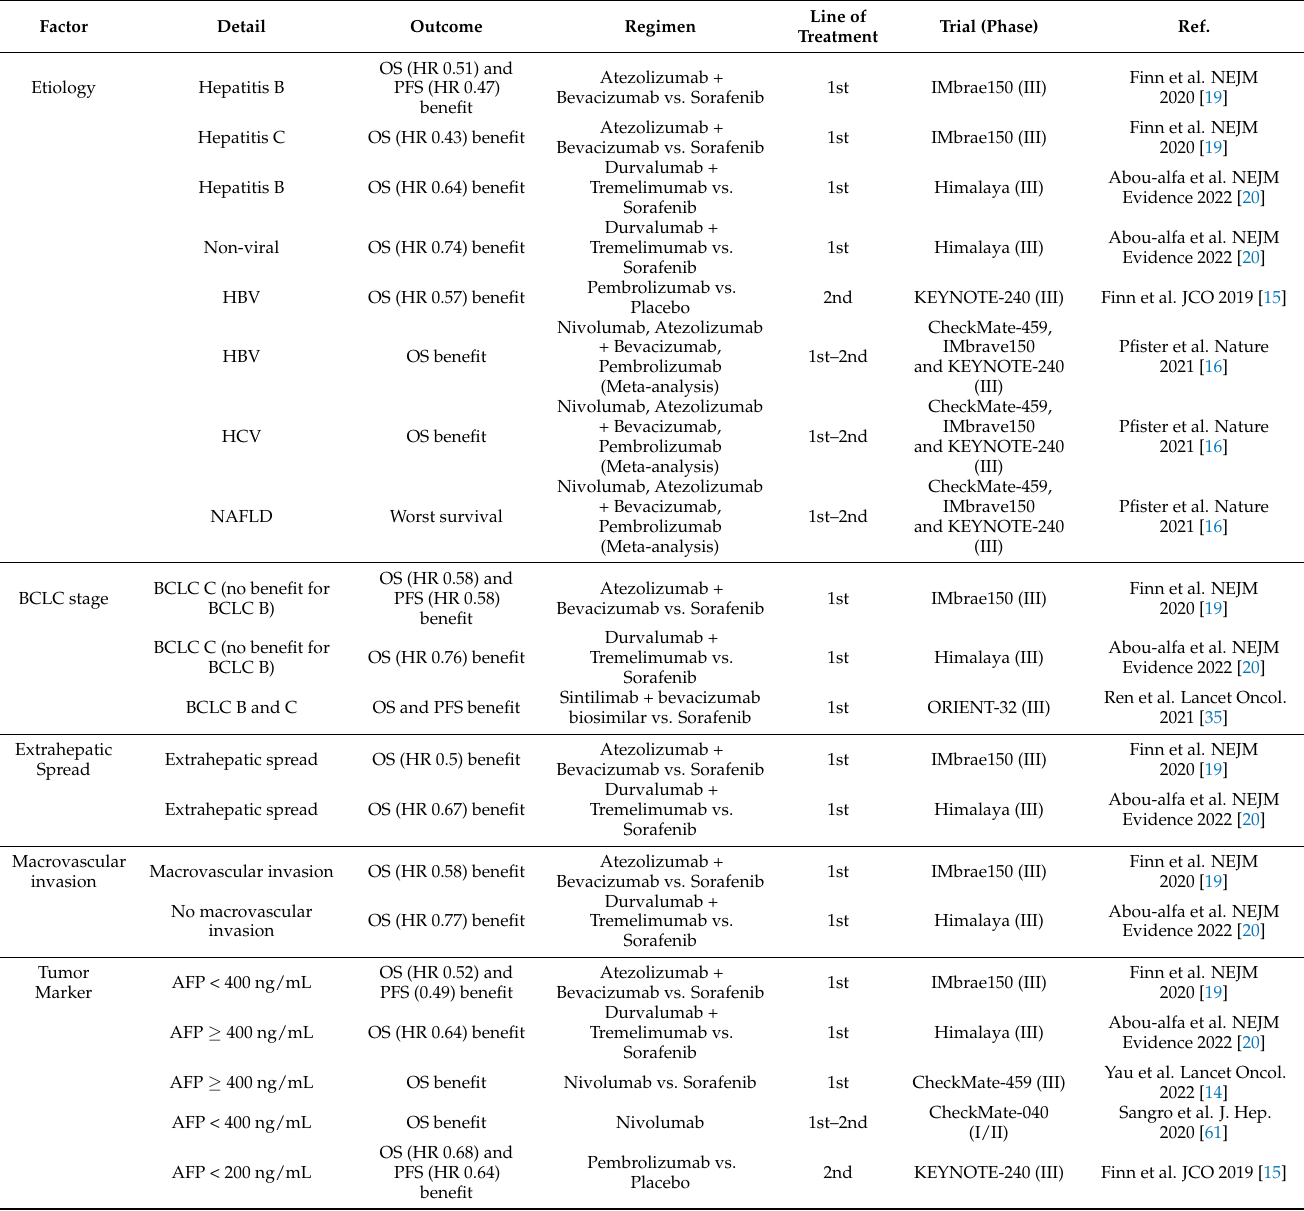
Table 1. Clinical